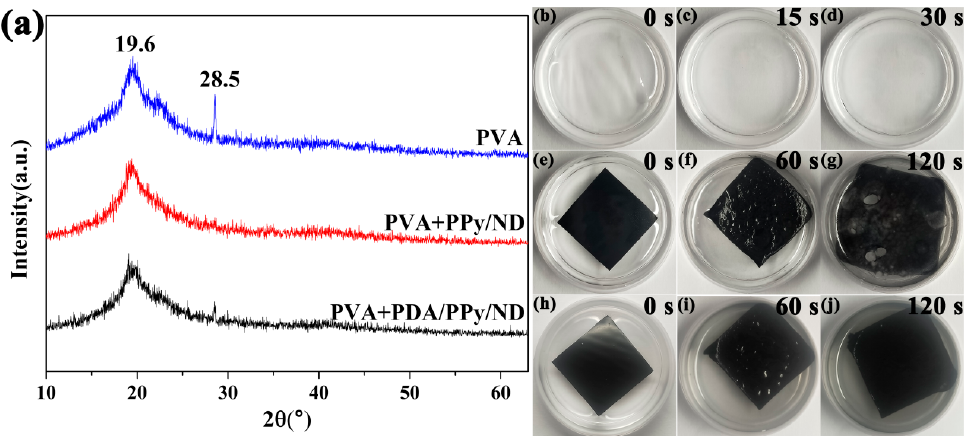
Figure 9. ( a ) The XRD patterns of the films, ( b – d ) the photographs of the PVA film after ultrasonication in water with corresponding times, ( e – g ) the photographs of the PPy/ND film after ultrasonication in water with corresponding times and ( h – j ) the photographs of the PDA/PPy/ND film after ultrasonication in water with corresponding times.